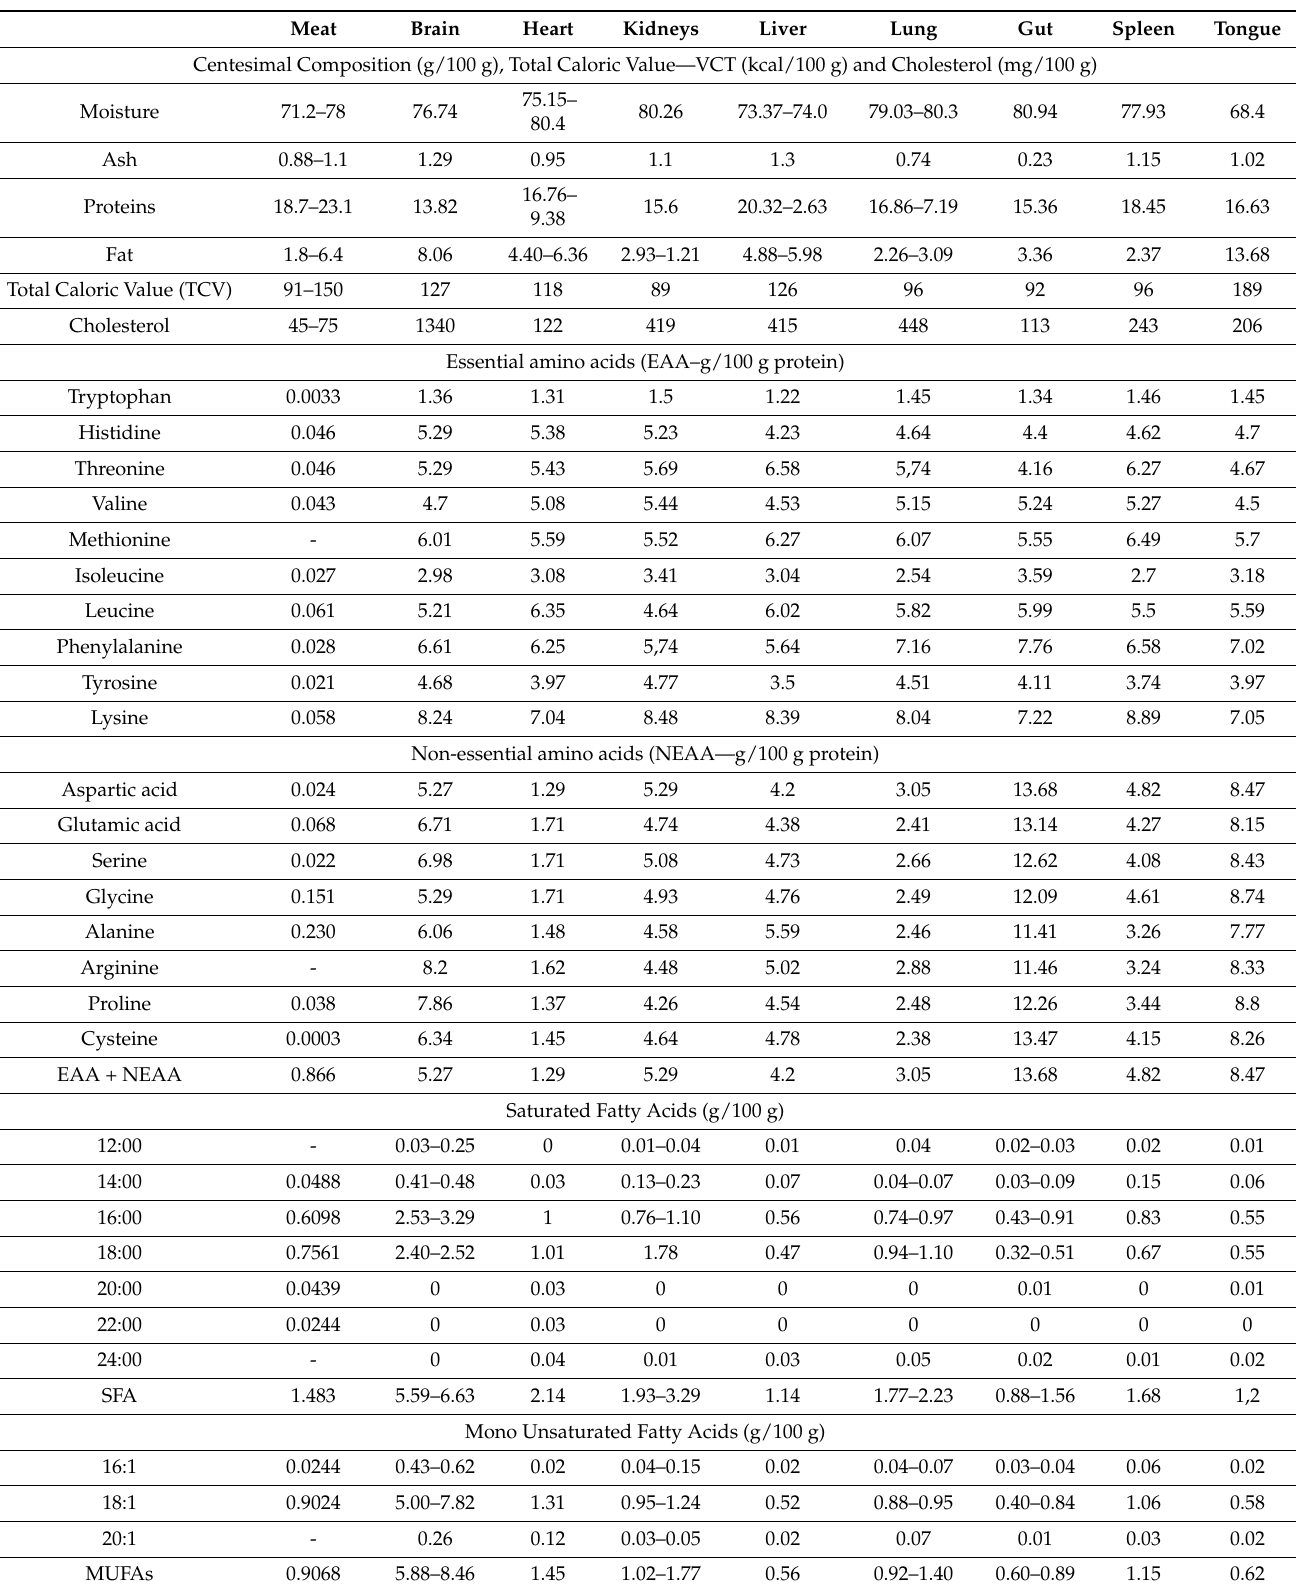
Table 1. Nutritional composition of goat meat and edible by-products. Meat Brain Heart Kidneys Liver Lung Gut Spleen